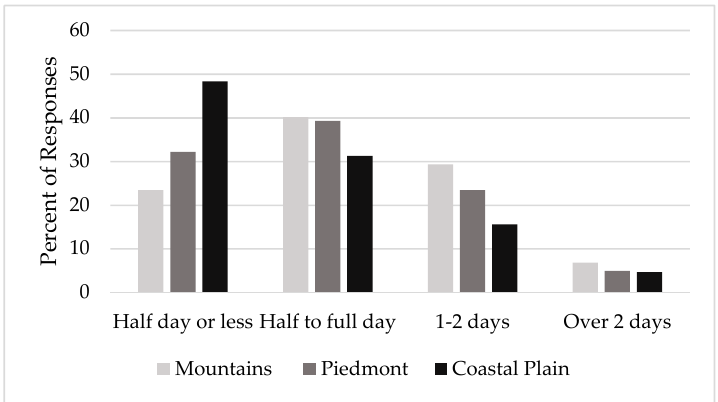
Figure 7. Typical time spent per tract on pre-harvest planning to locate roads, skid trails, landings, and stream crossings.